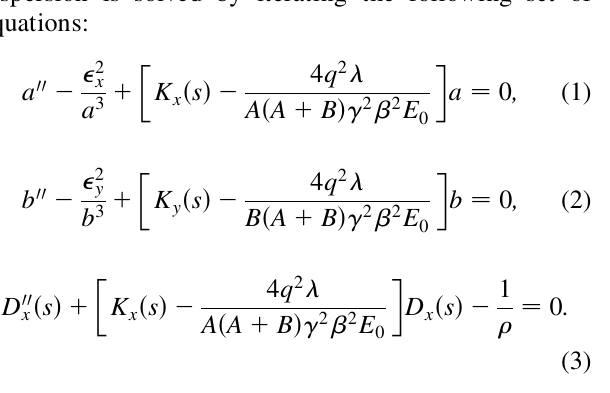
FIG. 8. (Color) Envelope tune (as calculated by an envelope model) versus turn number for the full intensity (red +’s), half intensity (blue (cid:11) ’s), and quarter intensity (green (cid:2) ’s) PSR